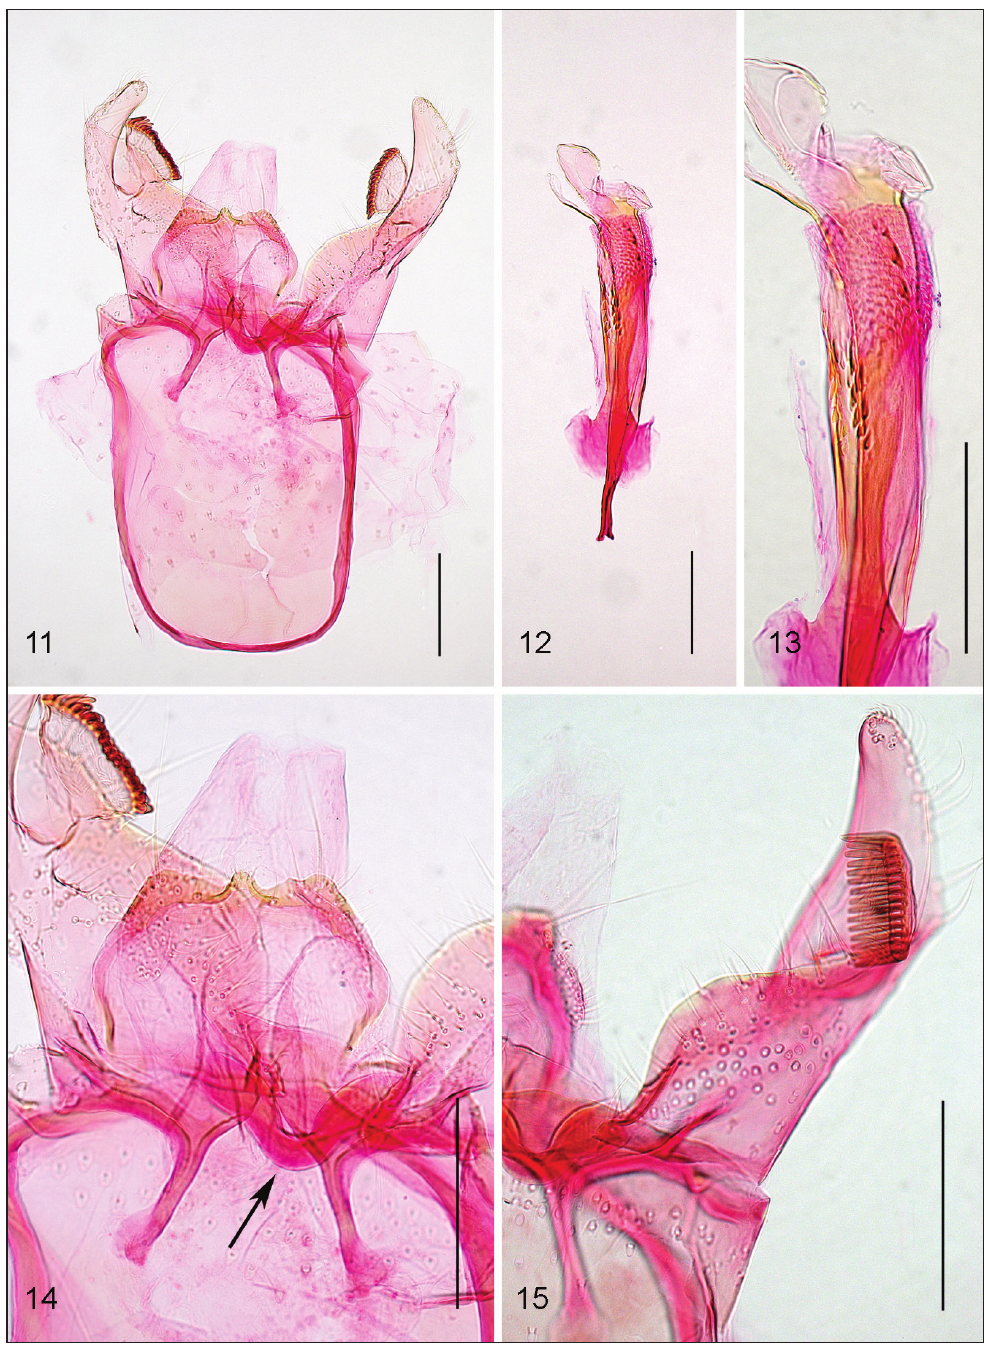
Figures 11–15. Antispila petryi , male genitalia, slides JCK8056, JCK8055 (15 only). Scales 100 μm ( 11–12 ), 50 μm ( 13–15 ). Arrow indicates anellus. Photos Erik van